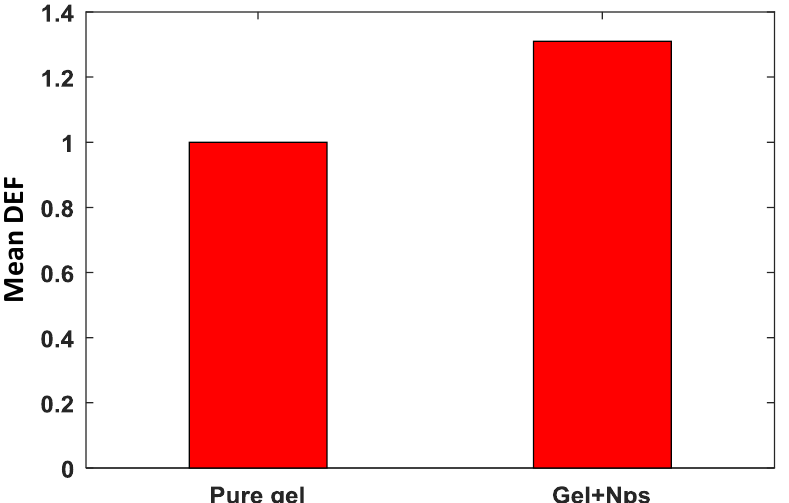
Figure 8 : DEF (%) in the presence of spherical bismuth oxide nanoparticles with a concentration of 0.1mM